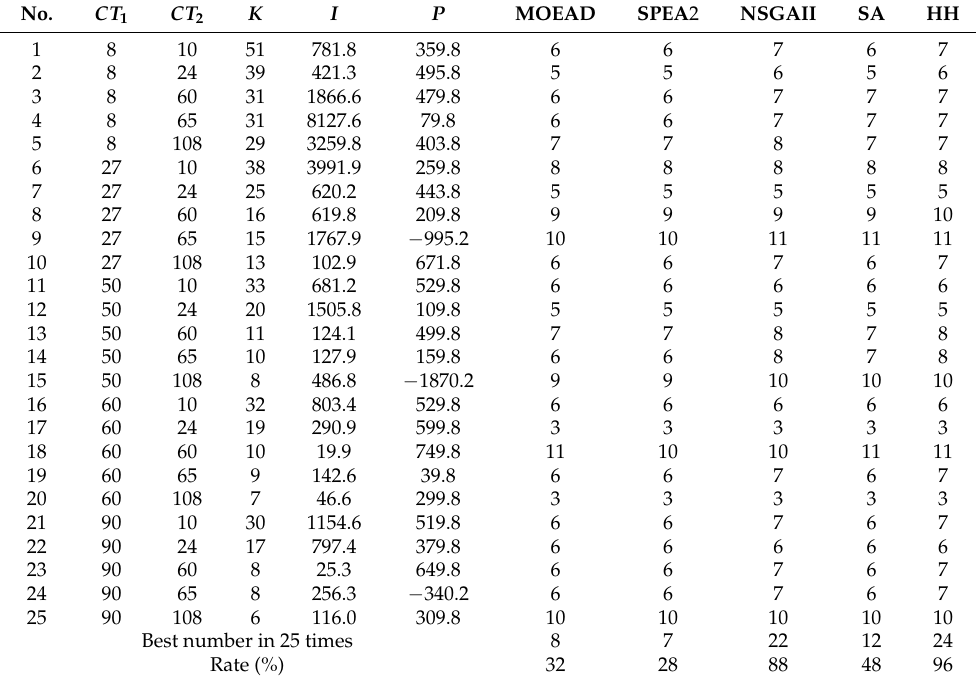
Table 9. Multi-objective optimisation results and the number of non-dominated solutions. No.